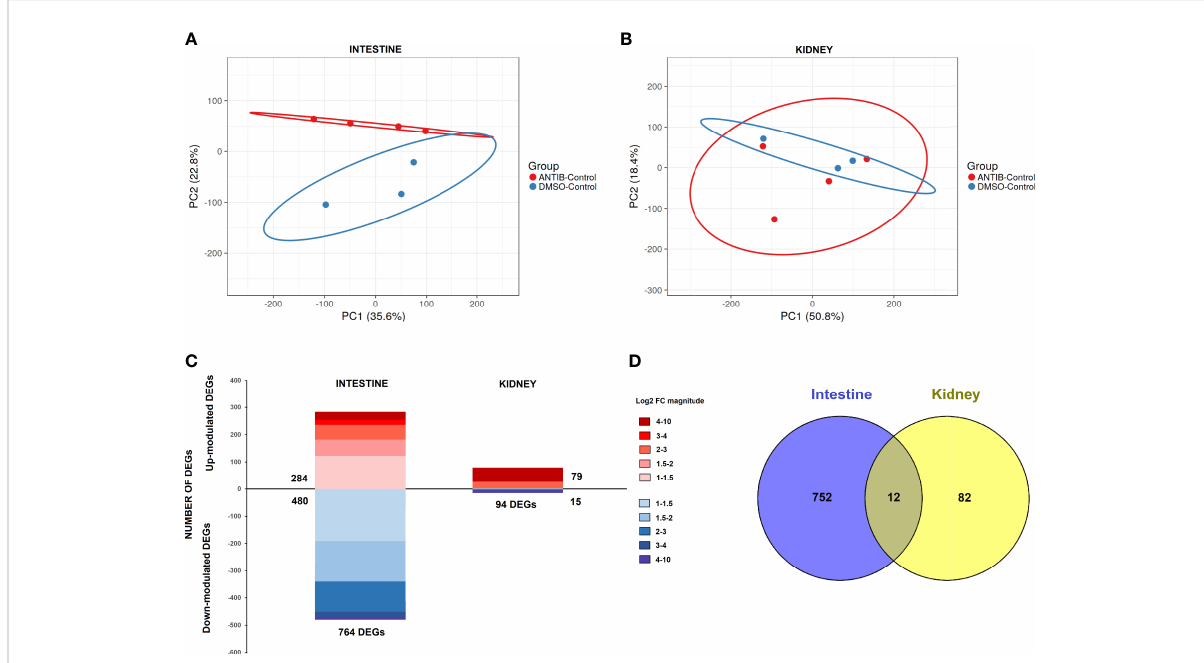
FIGURE 4 Comparative transcriptome analyses of zebra fi sh exposed to antibiotics or vehicle (DMSO) in the absence of infection. Principal component analyses (PCAs) of the (A) intestine and (B) kidney. (C) Stacked column charts re fl ecting the number and intensity (in log2 FC value) of the DEGs in the intestine and kidney of fi sh exposed to SMX+CLA for 2 weeks compared to the corresponding control (DMSO-treated fi sh). (D) Venn diagram showing the number of common and exclusive DEGs in the intestine and